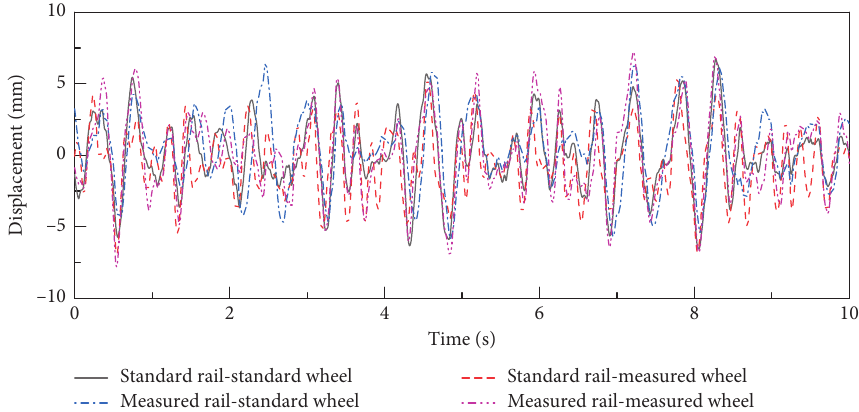
Figure 13: The lateral displacement of the first wheelset (110km/h).